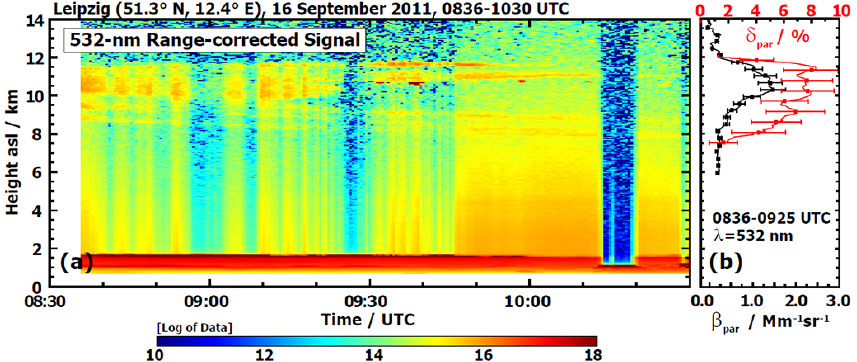
Figure 9. (a) Time-height cross-section of the 532nm range-corrected backscatter signal of the lidar system in Leipzig and (b) vertical profiles of particle backscatter coefficient β par (black curve) and particle depolarization ratio δ par with error bars (red curve) for the time interval 08:36–09:25UTC. The optical thickness (at 532nm) of the observed aerosol layer is derived to be